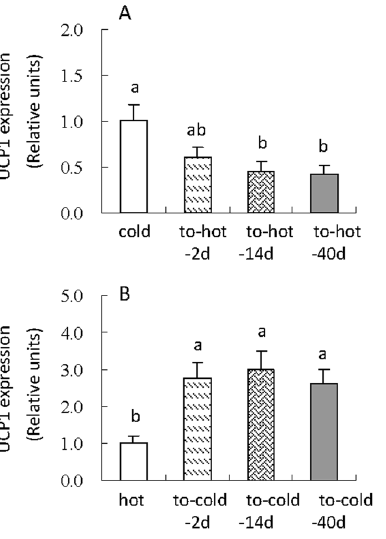
Figure 7. UCP1 gene expression of brown adipose tissue of striped hamsters during the transitions of cold to hot (A) and hot to cold condition (B). Different letters (a, b or c) above the columns indicate significant difference between the four groups ( P , 0.05). Data are means 6 s.e.m.